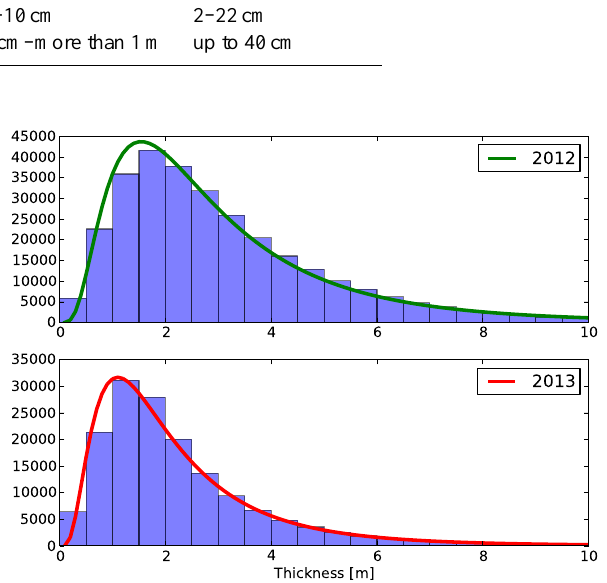
Figure 9. Sea ice thickness distribution derived from NASA’s Oper- ation IceBridge data from 2012 (upper panel, σ = 0 . 692) and 2013 (lower panel, σ = 0 . 695). The y axis is the number of